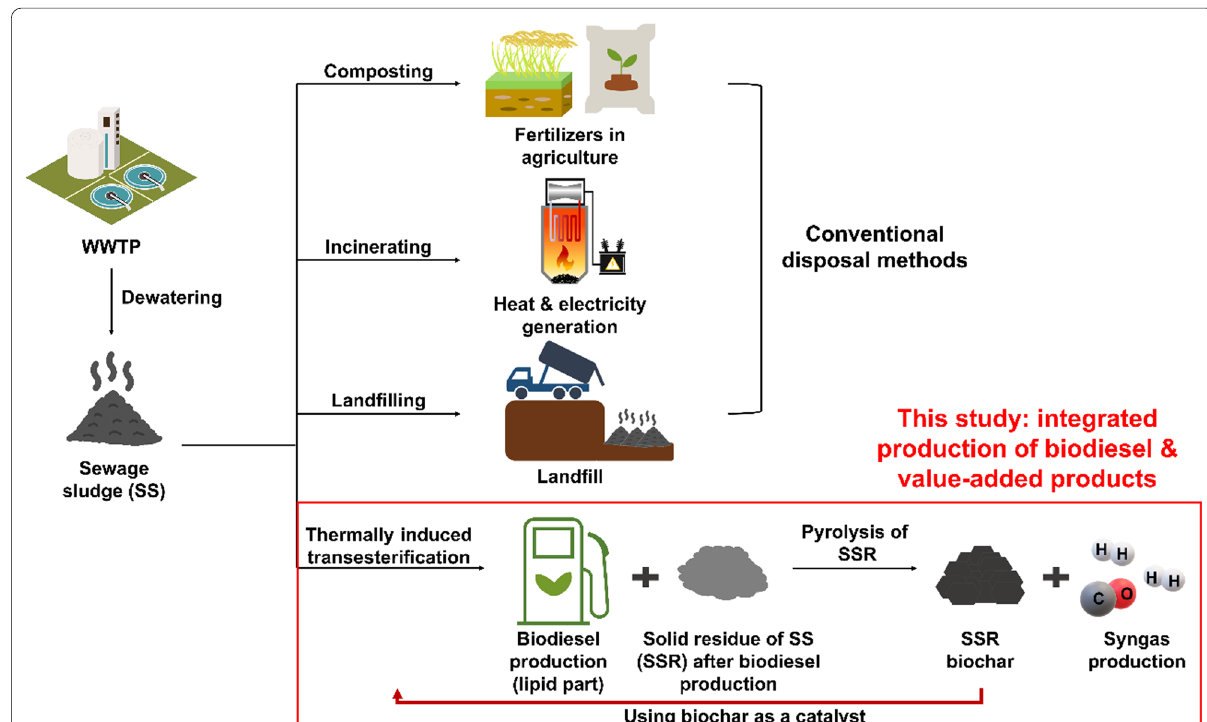
Fig. 9 Schematic of conventional SS disposal processes and suggested integrated processes for biodiesel production and value‑added